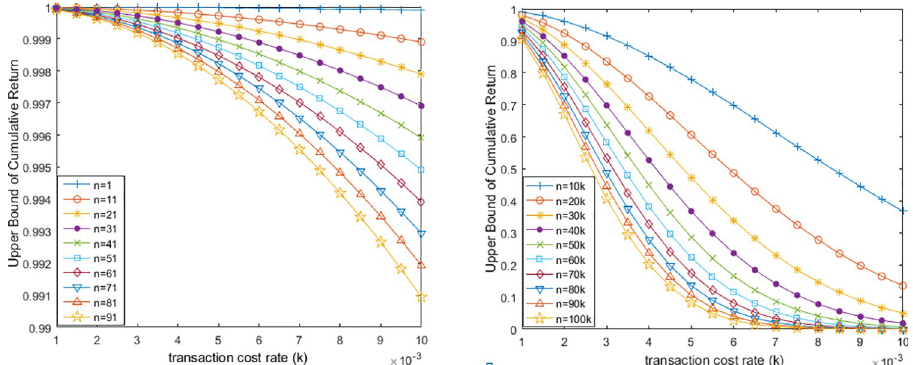
Fig 1. When � r � � k , the upper bound will decrease with the increase of k and n . Here the left sub-graph shows the situation when n is small (range from 0 to 100), while the right sub-graph shows the situation that when n is lager enough (range from 10,000 to 100,000). As shown in Fig 1, the upper bound exhibits a clear decreasing trend with the n and k